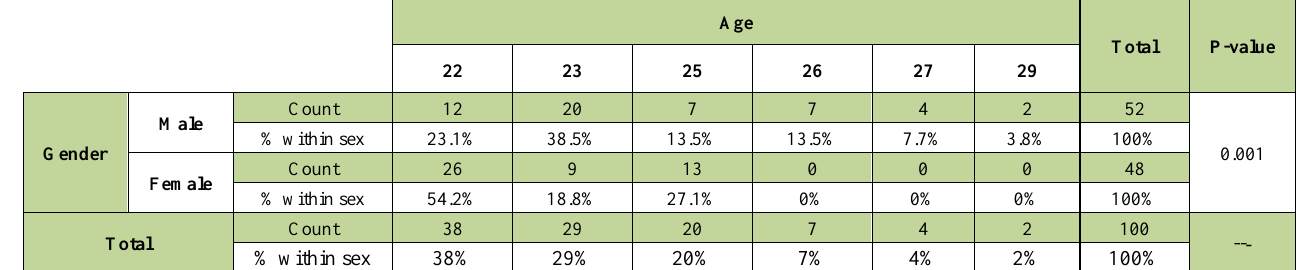
Table 1. Frequency distribution of the samples studied by gender.